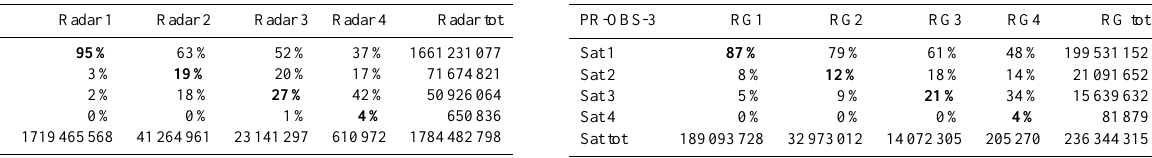
Table 14. Contingency table for the multi-categorical statistics for PR-OBS-3 as compared with radar-derived rain fields.